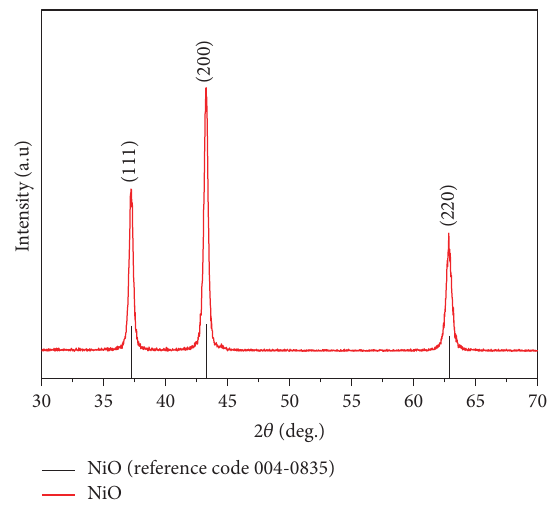
Figure 3: XRD patterns of NiO